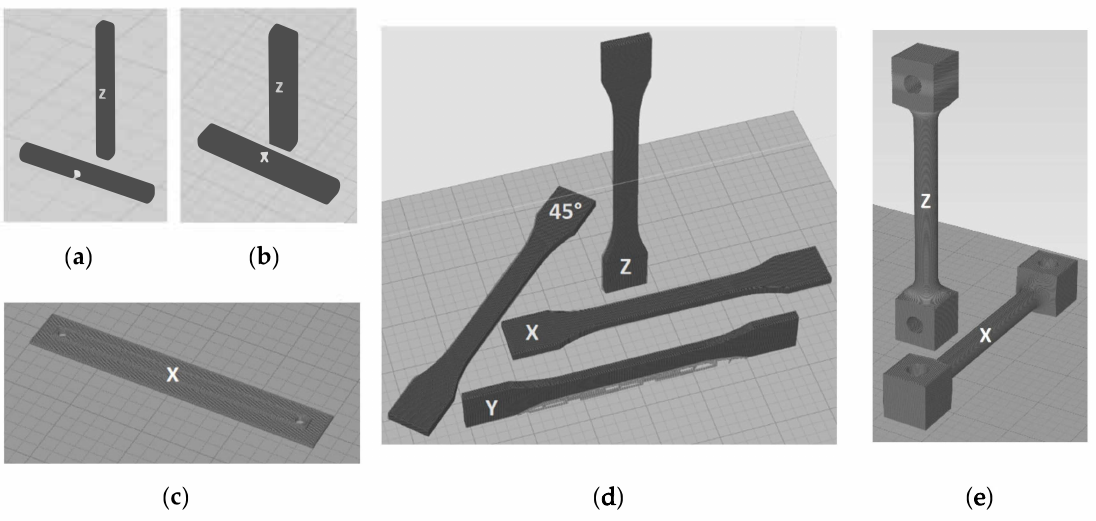
Figure 1. Printing orientations of the di ff erent test specimens in the CraftWare ™ software—screenshots. ( a ) Test specimens to determine the e ff ect of the layer height on resistance—specimen “A.” ( b ) Test specimens for measuring the e ff ect of the infill density on resistance—specimen “B.” ( c ) Test specimen for signal transfer capability—specimen “C.” ( d ) Test specimens for the tensile test strength. ( e ) Test specimens for the torque strength